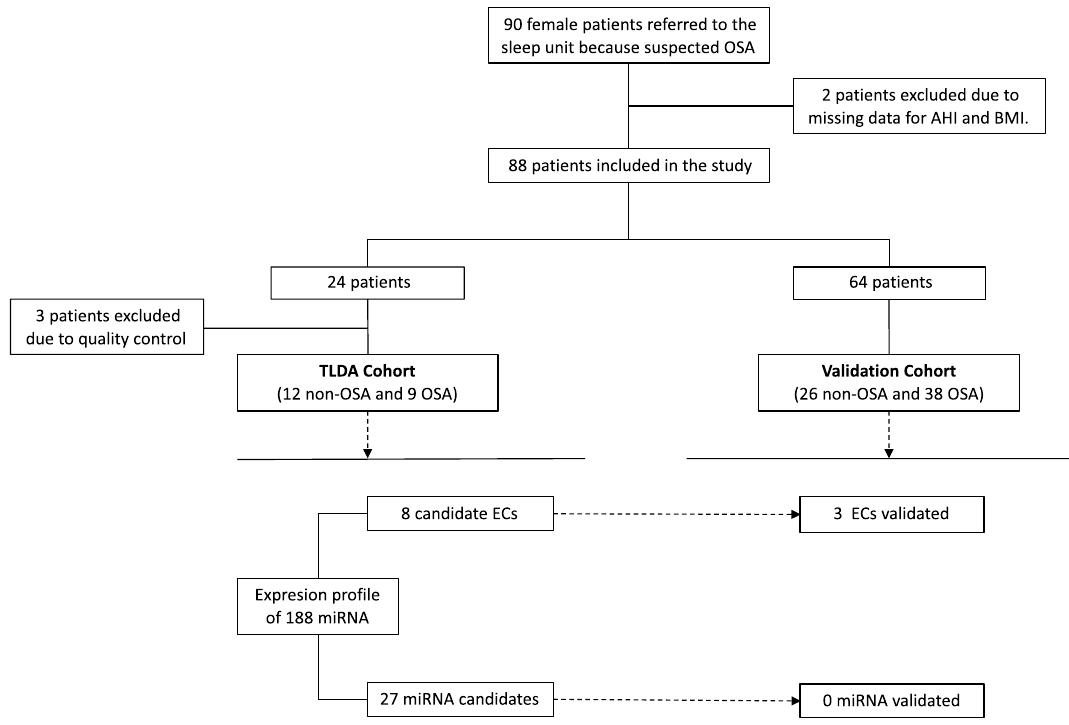
in an independent cohort of 64 females. OSA: Obstructive sleep apnea; TLDA: TaqMan-Low-Density-Array; miRNA: microRNA; mean-centre + SD: mean-centre + standard deviation; CCR: Concordance correlation restricted ; AHI: Apnea–hypopnea index; BMI: Body mass